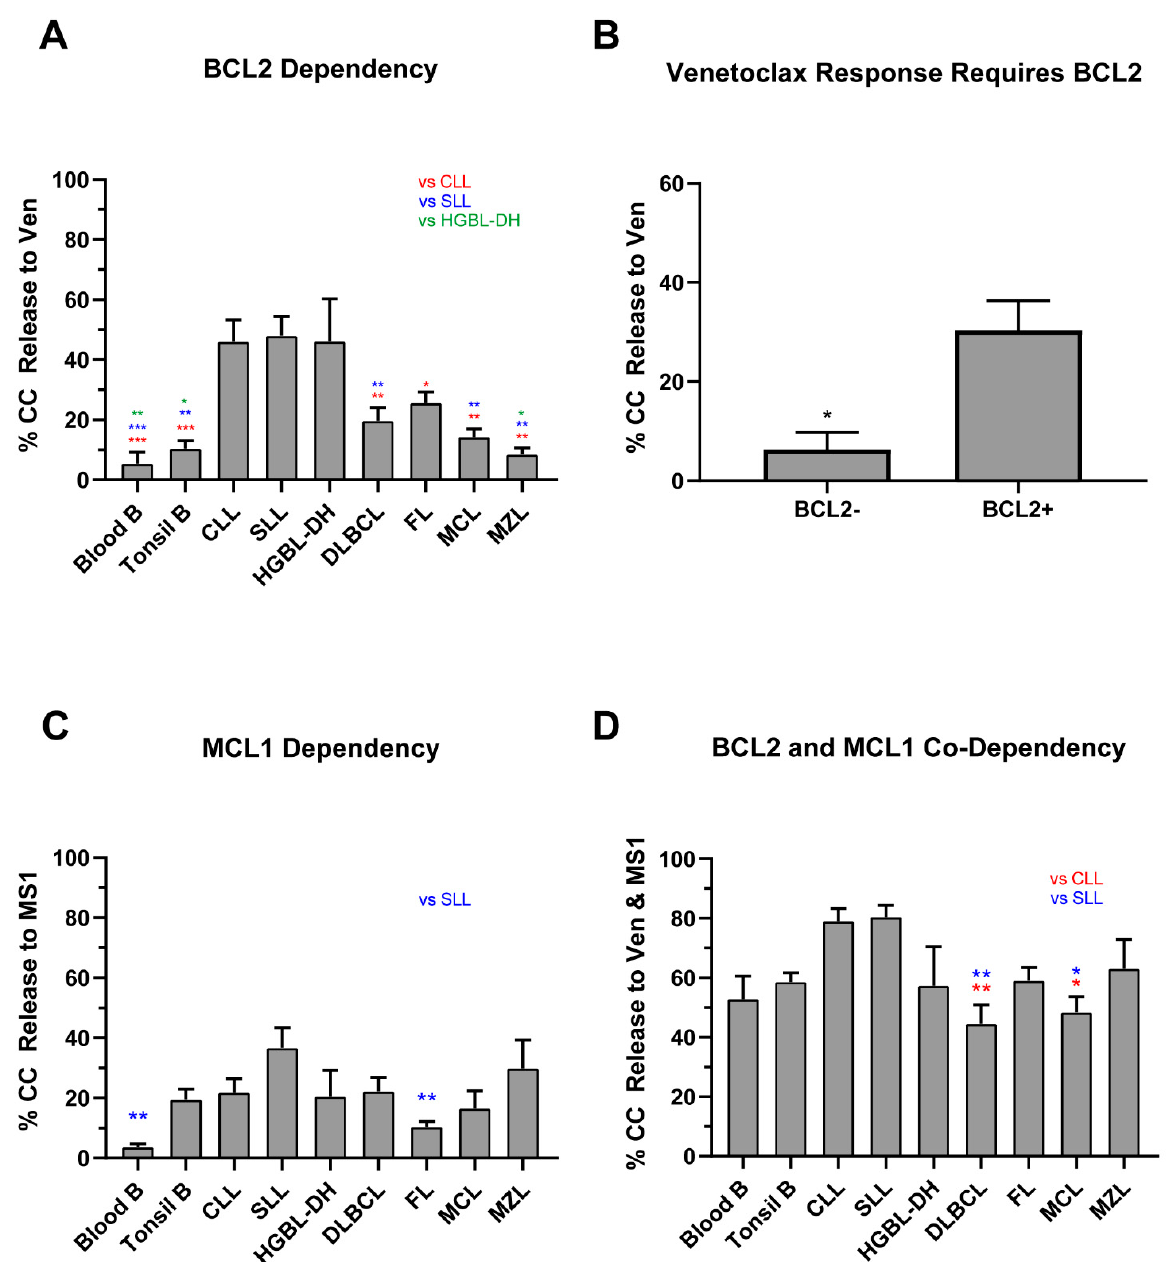
Figure 4. Sensitivities to BCL2 and MCL1 inhibition according to lymphoma subtype. We measured cytochrome c release, displayed on the y -axis, after exposure to 1 µM of venetoclax and 10 µM of MS1 in different lymphoma subsets ( x -axis). A one-way ANOVA with Tukey multiple comparison was used to determine statistical significance between NHL subtypes. Bars represent the mean ± standard error of mean (SEM). ( A ) Comparison of lymphoma subtypes based on venetoclax response. CLL, SLL, and HGBL-DH showed notable responses to BCL2 inhibition. ( B ) Venetoclax responses in DLBCL and HGBL-DH samples according to BCL2 protein expression (present in >50% of cells). Venetoclax responses were not seen in high-grade NHL in the absence of BCL2. T-test with Welch’s correction was applied to assess significance. ( C ) MS1 responses in lymphoma subtypes. SLL displays the greatest response to single MCL1 inhibition. ( D ) NHL response to dual inhibition of BCL2 and MCL1 by venetoclax and MS1. All subtypes display increased responses when compared to singular inhibition. * p < 0.05, ** p < 0.01, *** p < 0.001. Abbreviations: CLL, chronic lymphocytic leukemia; FL, follicular lymphoma; DLBCL, diffuse large B cell lymphoma; HGBL-DH, high grade B cell lymphoma with translocations in MYC and BCL2 ; MCL, mantle cell lymphoma; MZL, marginal zone lymphoma.